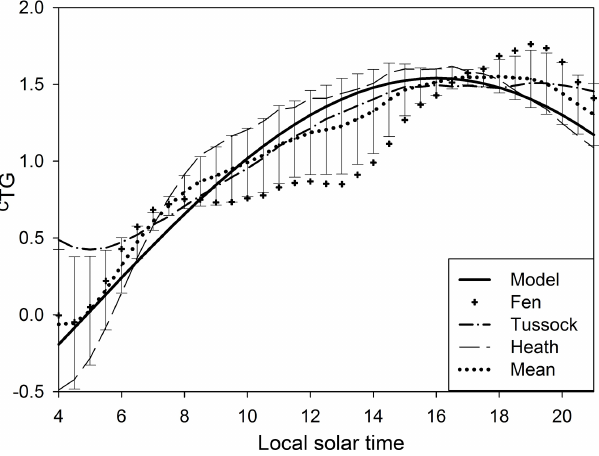
Figure 3. Time series of modeled c TG and observed c TG values from the Fen, Tussock and Heath flux stations as well as mean val- ues for summer conditions (bars represent standard deviation of the